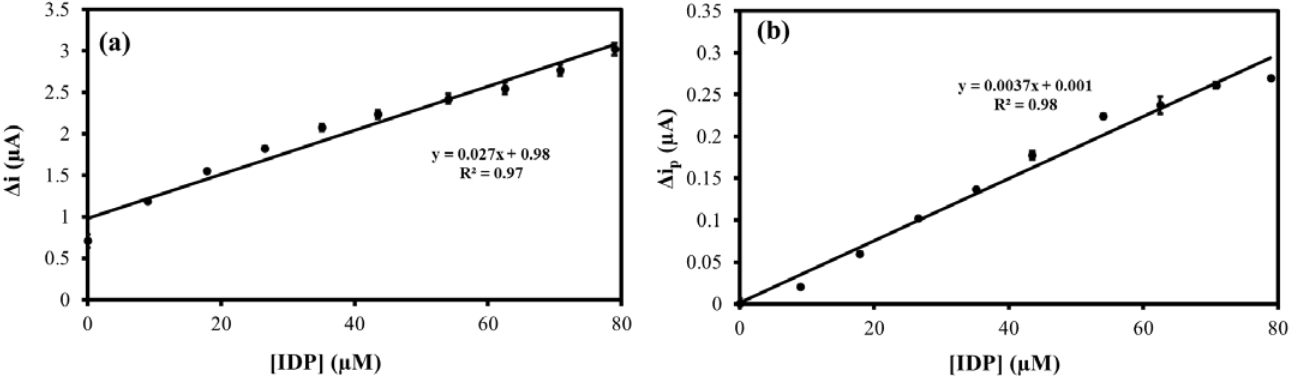
Figure 9. ( a ) Average CV current ( ∆ i); and ( b ) Peak DPV current ( ∆ i p ) vs. imidacloprid (IDP) concentration standard addition calibration for honey sample analysis using the MIP@CNT/CNC MN